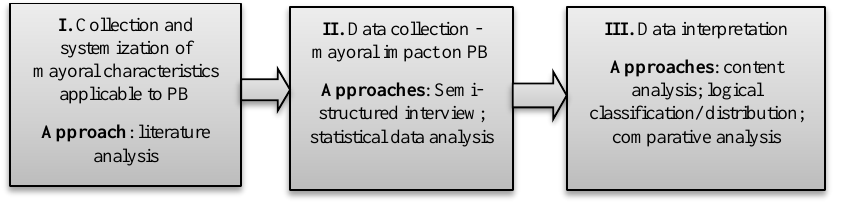
Figure 1. Research flowchart